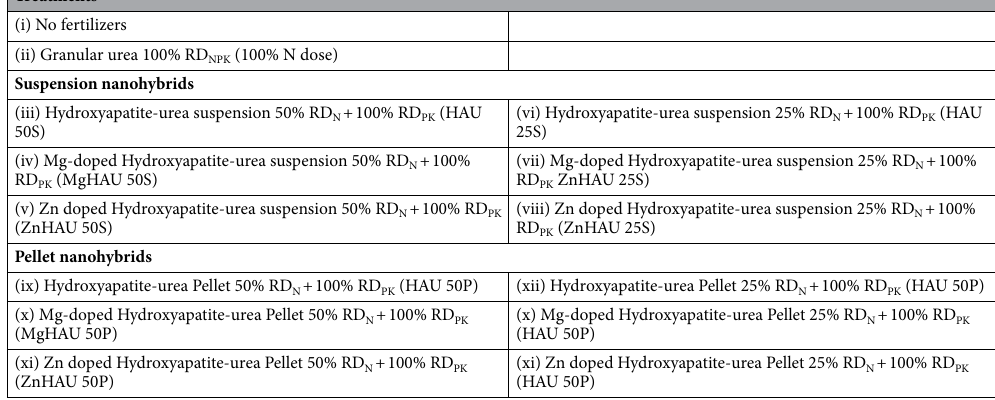
Table 2. The fertilizers treatment scheme used in the study. All the treatments were replicated three times.